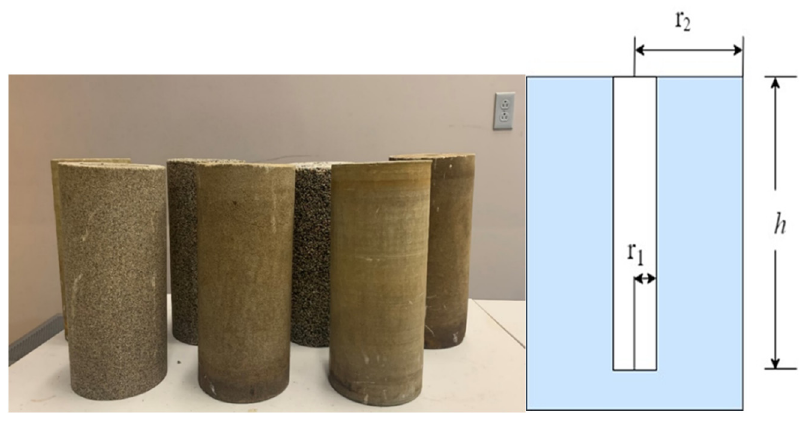
Figure 1. Seven artificial samples.